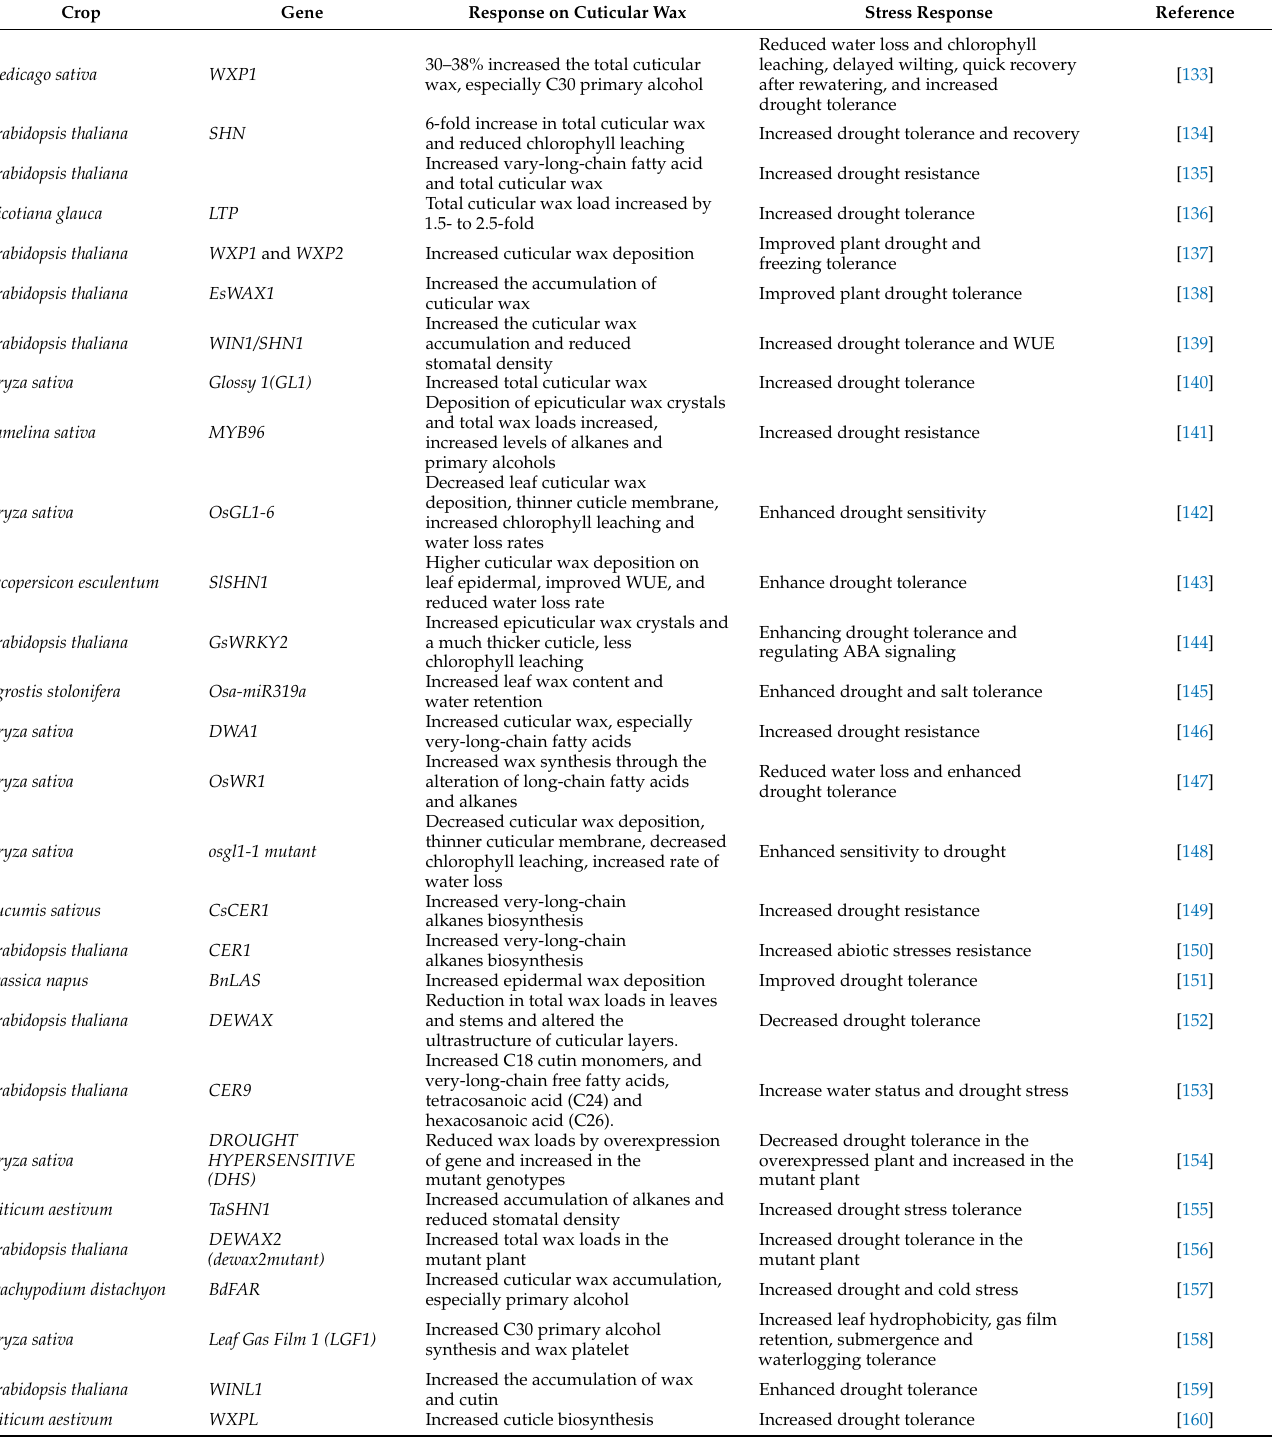
Table 4. Genes involved in cuticular wax biosynthesis in plants under osmotic stress